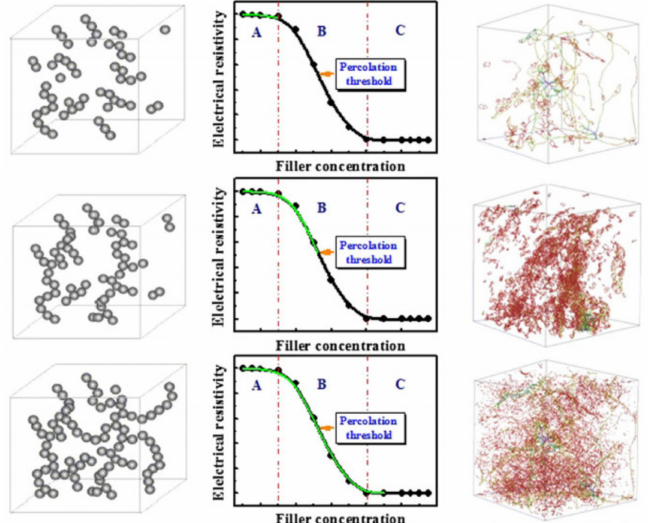
Figure 4. Variation of the electrical resistivity with change of functional filler concentration. Repro- duced with permission from [44], Elsevier,